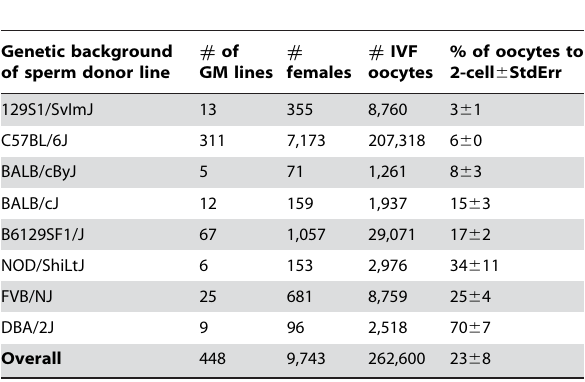
Table 1. Dependency of impaired fertility on the genetic background of cryopreserved mouse sperm.